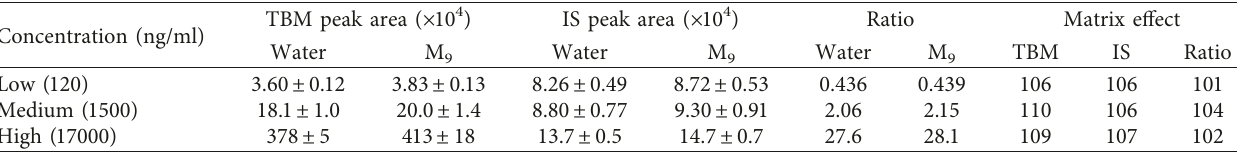
Table 3: Matrix effect.